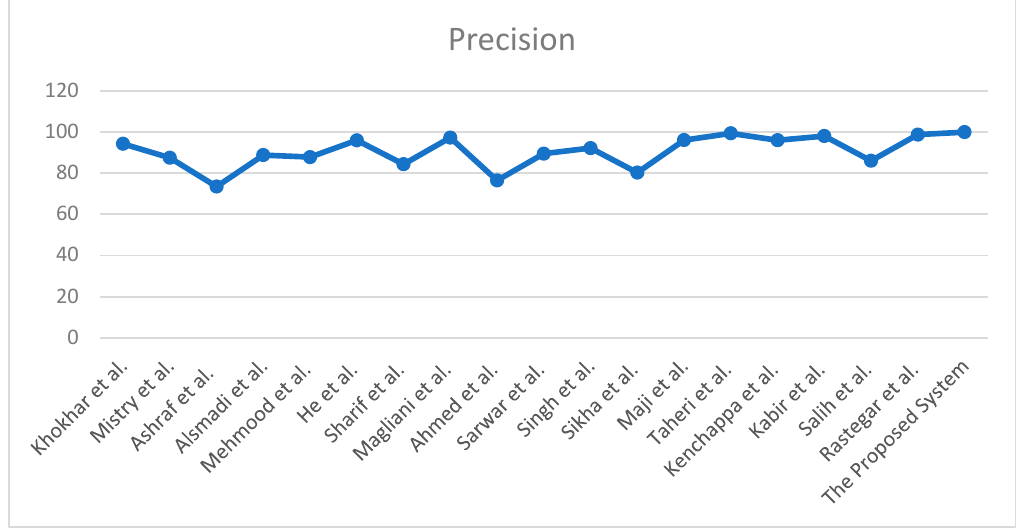
Figure 8. Comparison with existing techniques. Table 5. Comparison of precision with existing techniques.